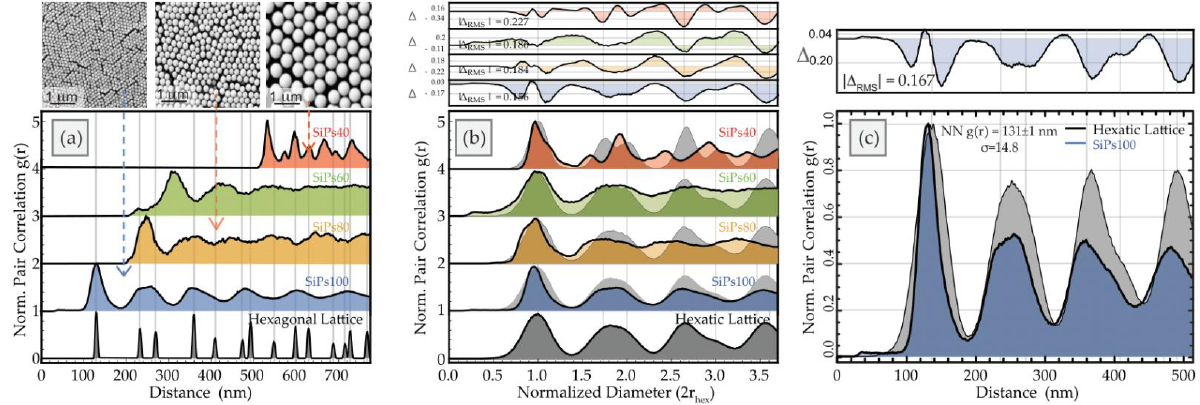
Figure 5. Pair correlation functions g(r) of centroids obtained from SEM images of PS inverse opals. Colored arrows show the corresponding SEM image resulting in the pair correlation function ( a ) Measurements of objects shows that the peak positions are misaligned. This confirms how the average spacing between particles is inversely correlated with the amount of solvent addition. The expected g(r) for a hexagonal lattice with similar intensity (average particles per unit area) as SiPs100 is shown for comparison. ( b ) Normalizing the distance to the average spacing (2r hex ) of a hexagonal lattice with the same number density (located at particle positions) collapses the distributions into a shared spatial reference frame where peak positions can easily be compared. The smallest and largest diameter particles show correlation with the hexagonal lattice of similar intensity (average particles per unit area) for more than 4 degrees of order (peaks in the correlation function). For the intermediate diameters only one or two degrees of order are observed, indicating a larger amount of disorder in those systems. ( c ) The differences in g(r) are shown as the grey sections on an overlay of pcf from SiPs100 particle distributions and that of the matched hexatic lattice. The widths of these peaks correspond to the average mean displacement each particle has relative to this expected spacing. The inserts above ( b , c ) show the difference spectrum, which is the subtraction between a pair correlation function and the hexatic lattice. regions with Voronoi cells of high hexagonal entropic order (uncolored cells in Figure 6), pair correlation analysis). This suggests roughly hexagonal symmetry arrangements, but